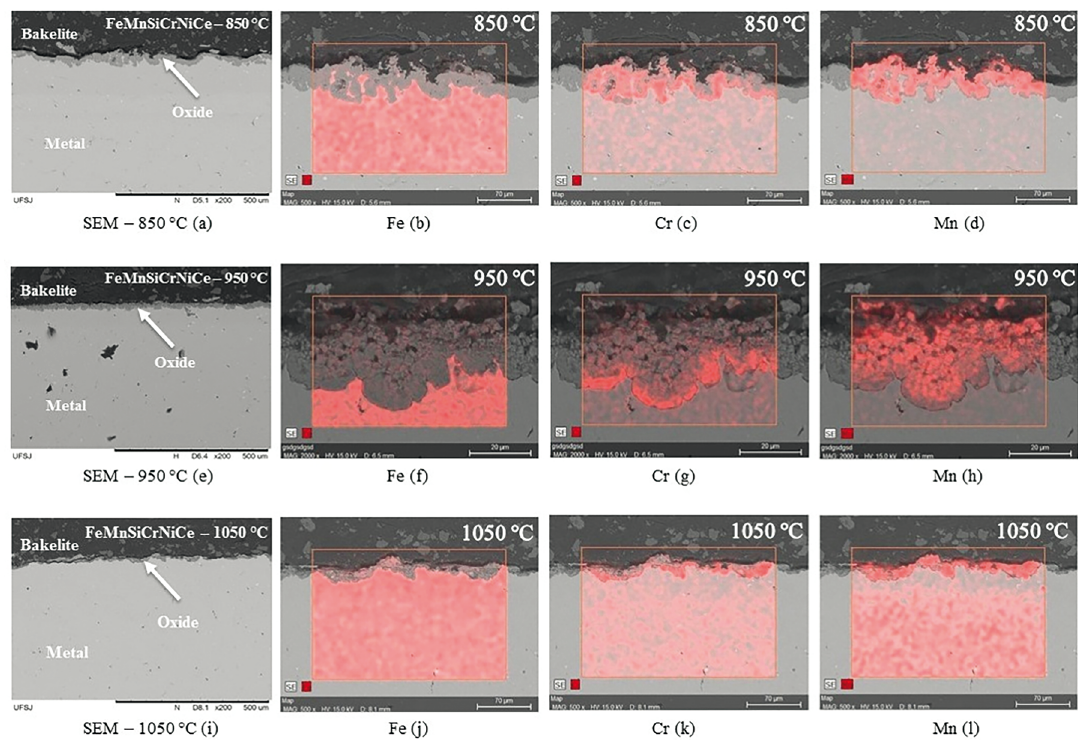
Figure 6. SEM/EDS of cross section of the FeMnSiCrNiCe alloy after cyclic oxidation at 850, 950 and 1050 ºC.